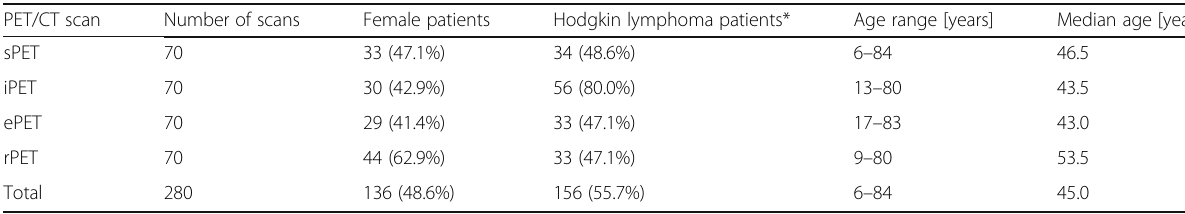
Table 1 Patient characteristics in the subgroups PET/CT scan Number of scans Female